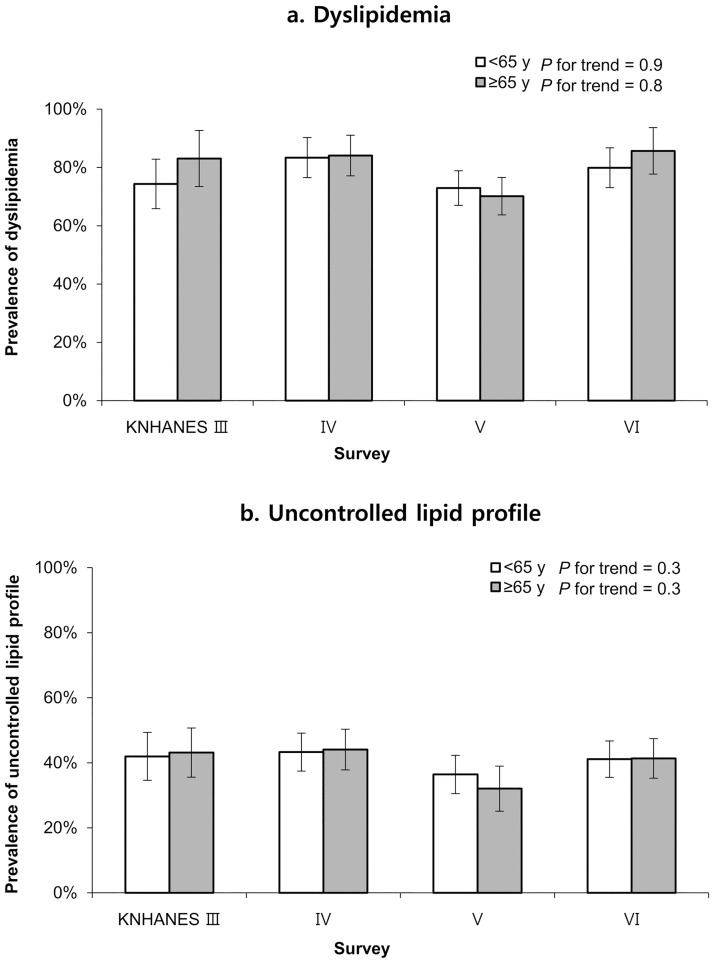
The prevalences of uncontrolled lipid profile and dyslipidemia among patients with diabetes mellitus according to age group and survey period.Values are adjusted for sex, medication use, smoking status (current smoker, previous smoker, or never smoker), alcohol consumption (<1 vs. ≥1 drink/day for women or <2 vs. ≥2 drinks/day for men), body mass index (<23 kg/m2 or ≥23 kg/m2), education level (less than high school or more than high school), duration of diabetes, and psychosocial stress.